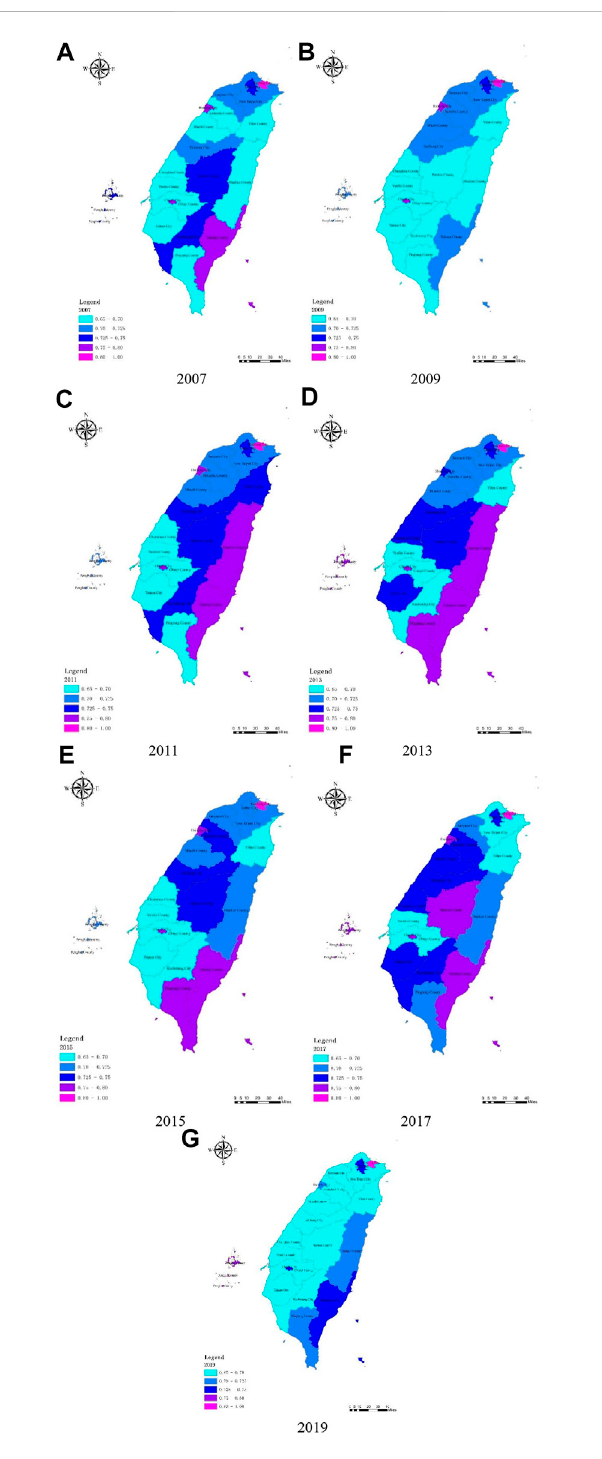
FIGURE 2 Agricultural production ef fi ciency of various counties and cities